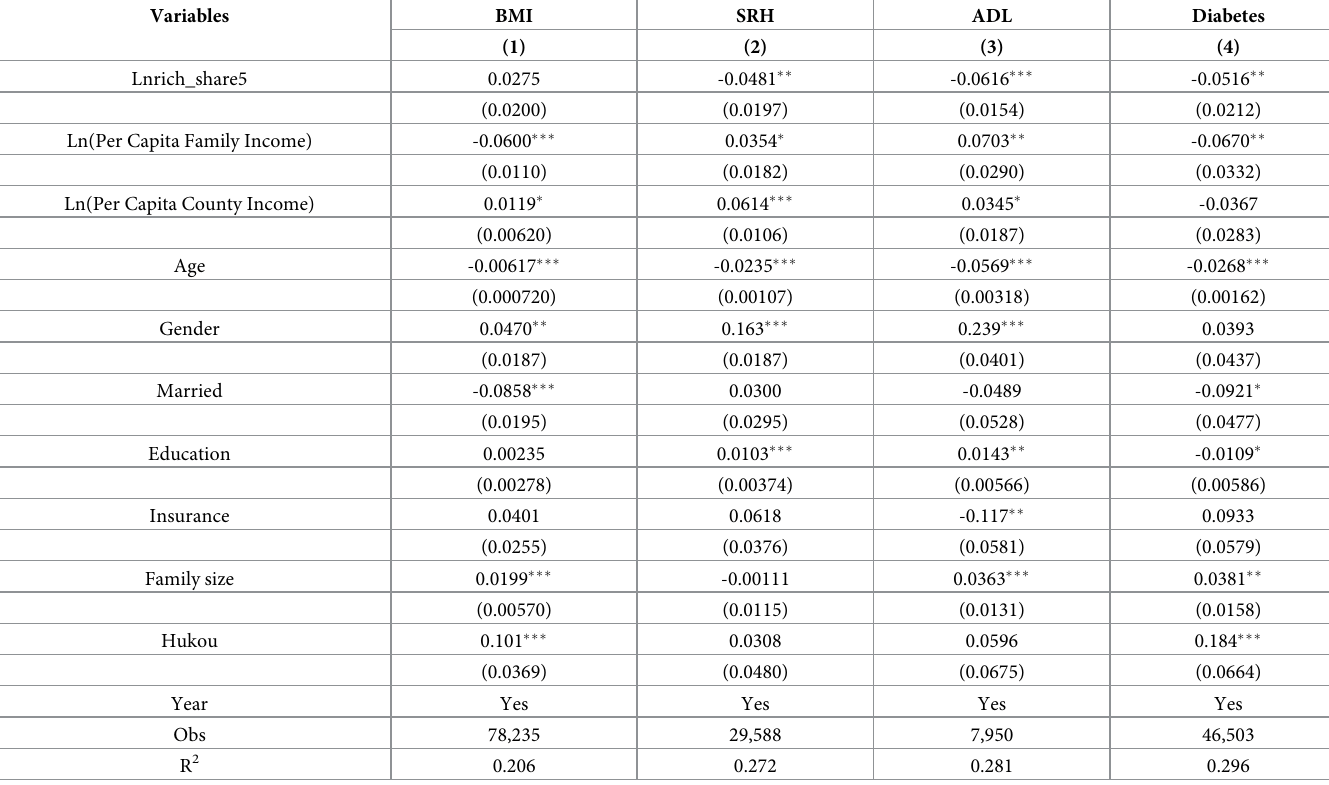
Table 2. The effects of rich share (5%) on individual